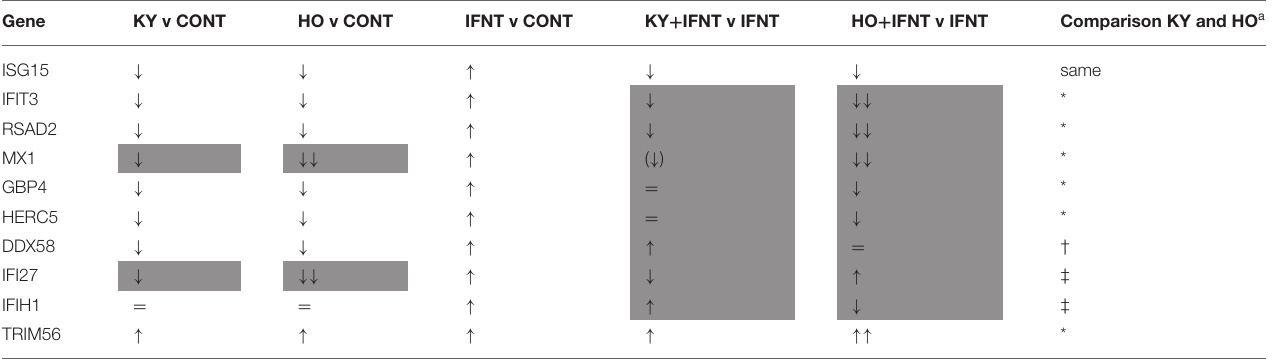
TABLE 2 | Summary comparison of the effects of KY1203 (KY) and Ho916 (HO) strains of ncpBVD-1 on gene expression by cultured bovine uterine endometrial cells, with or without IFNT stimulation. Gene KY v CONT HO v CONT IFNT v CONT KY + IFNT v IFNT HO + IFNT v IFNT Comparison KY and HO a